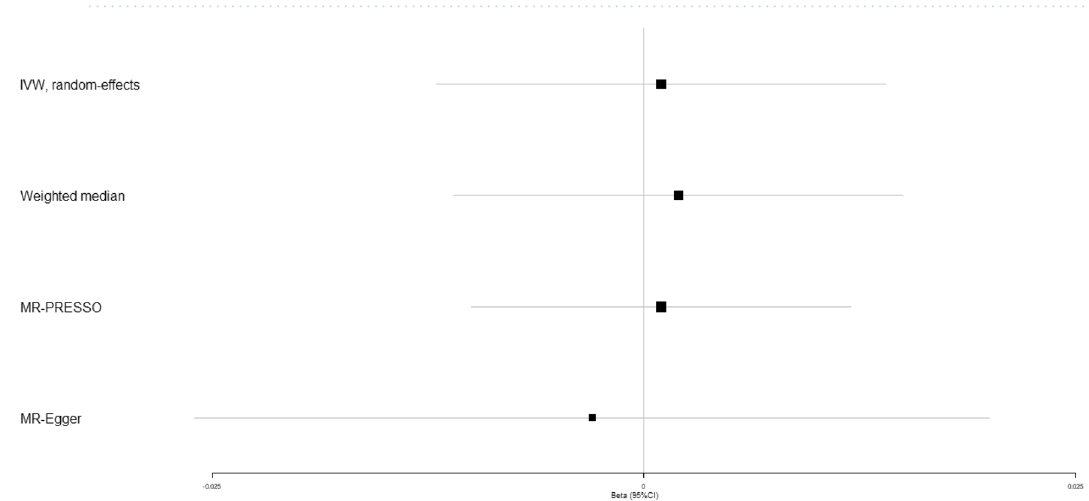
Figure 3. Beta (95% CIs) for causal influence of circulating adiponectin on heart failure through multiple analyses.